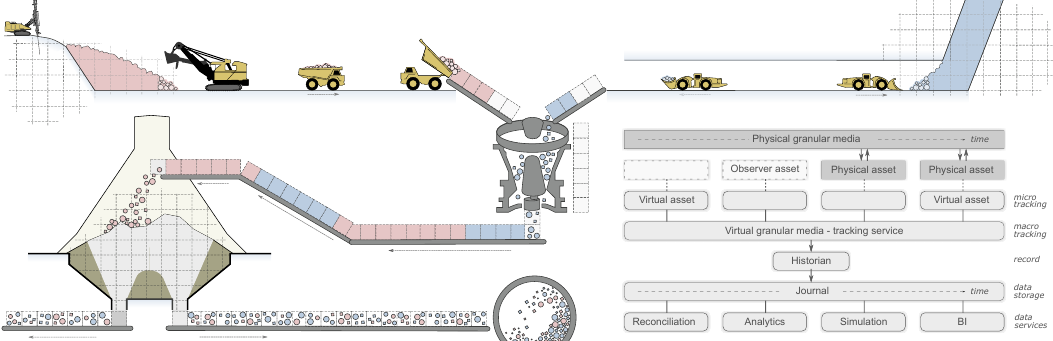
Figure 1. Illustration of a mine-to-mill process with particle-based material tracking. The chain of processes includes: drilling; blasting; load, haul and dump; conveying; crushing; sizing; storage and reclaim; and grinding; which then lead to a concen- trator. The processes are carried out by physical assets that perform unit operations on the material. Connected virtual assets mirror the operations by transforming a distributed digital representation of the material. The architecture of the system of assets and services for tracking, data storage and analytics is illustrated in the lower